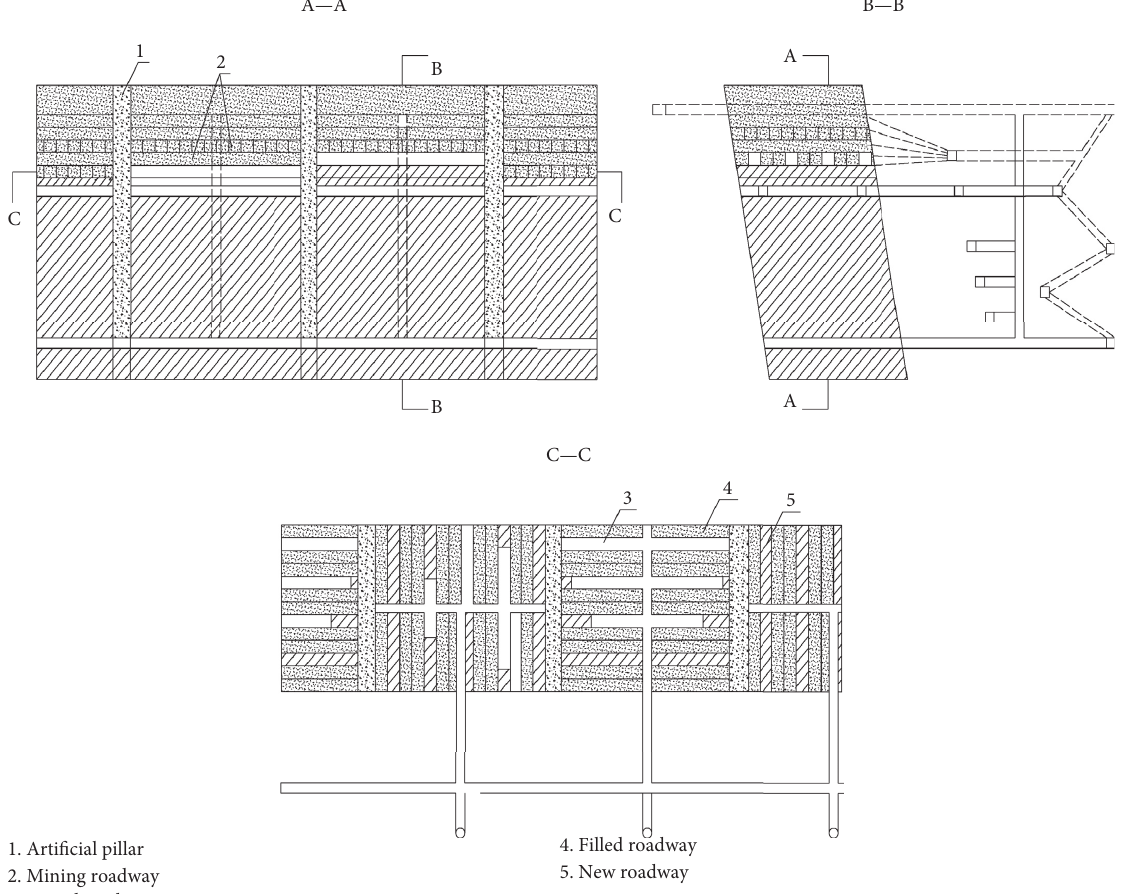
Figure 3: Design of the partitioned unloading panel large-section downward mining